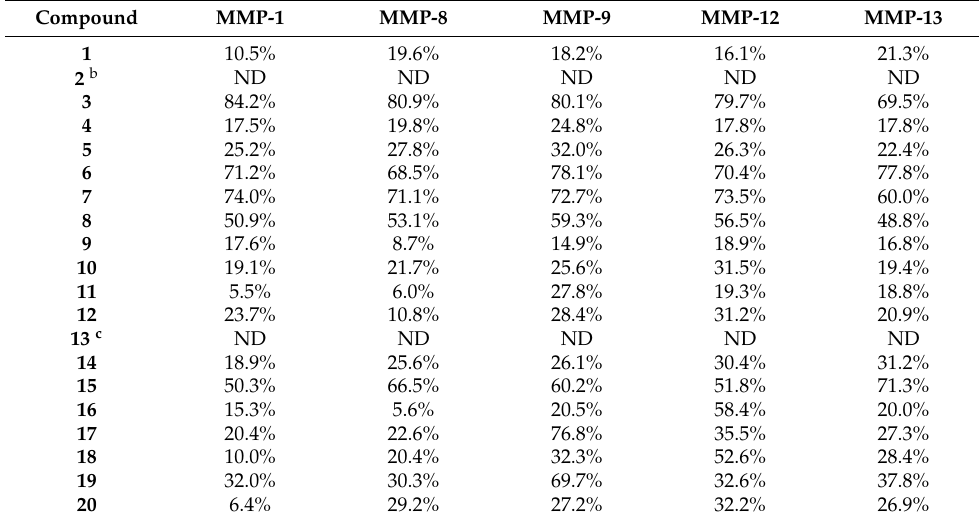
Table 4. MMP inhibitory activity of the compounds tested (inhibition % at 100 µ M) a . Compound